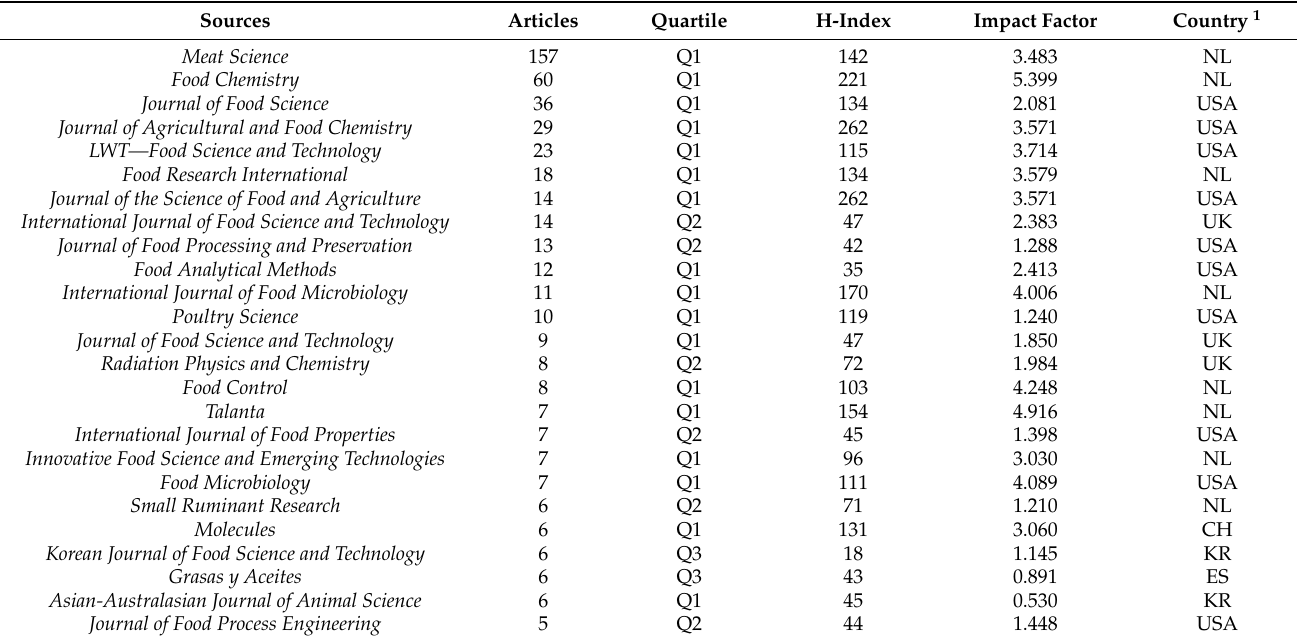
Table 2. Ranking of the top 25 of 98 journals that published articles on VOC profiles of meat in 2000–2020 according to the number of articles they published, the quartile in their highest subject category, and their H-index, impact factor and country of